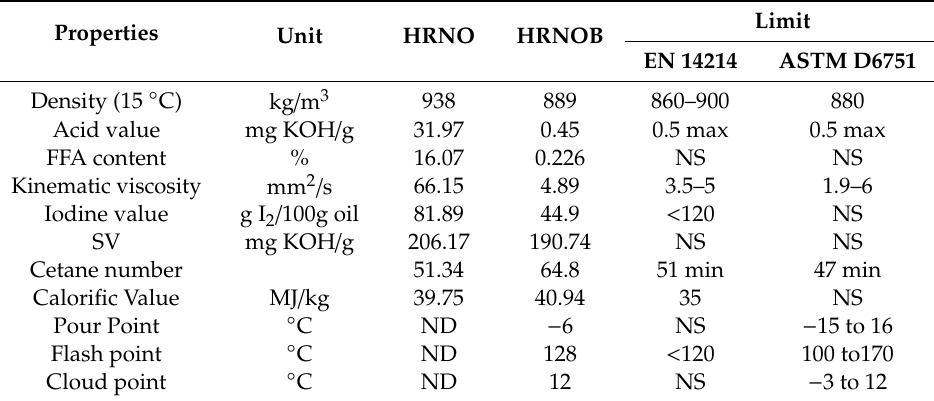
Table 6. Properties of HRNO, HRNOB and